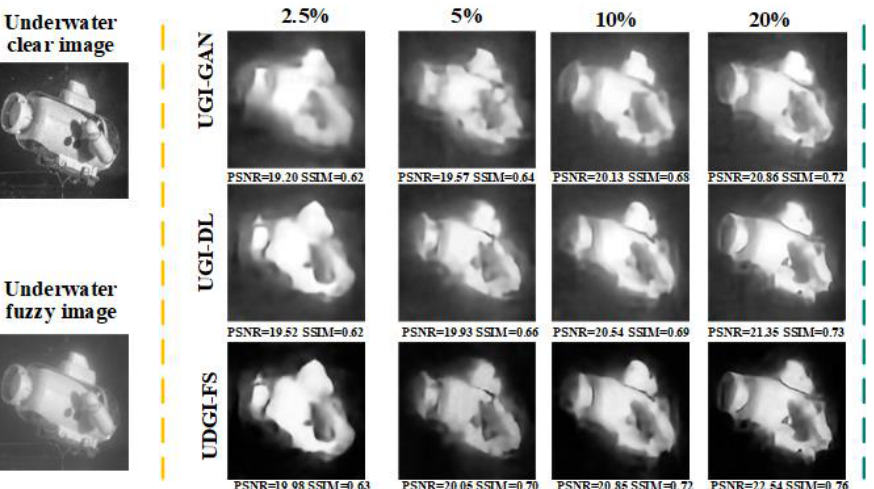
Figure 18. Comparison of reconstructed submarine images of UDGI-FS, UGI-DL, and UGI-GAN at different sampling rates.